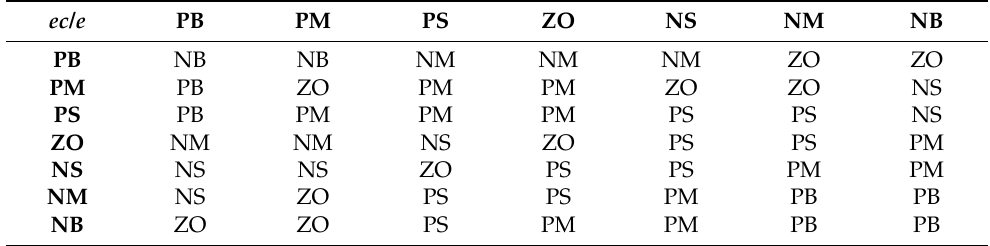
Figure 5. Fuzzy rule inference relation diagram of ∆ k P , ∆ k I , and ∆ k D . ( a ) Fuzzy rule inference relation diagram of ∆ k P . ( b ) Fuzzy rule inference relation diagram of ∆ k I . ( c ) Fuzzy rule inference relation diagram of ∆ k D . Table 2. Fuzzy rule control table of ∆ k P